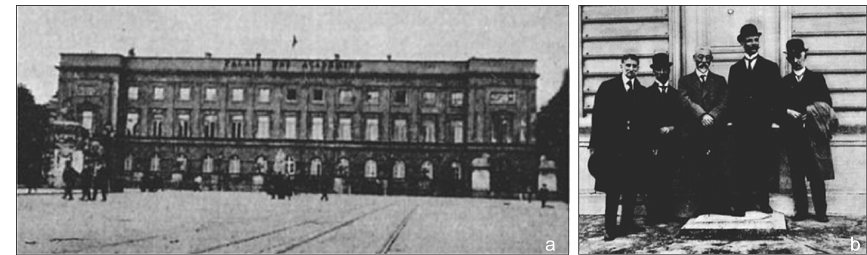
Figure 3. The inaugural IRC General Assembly and establishment of IUGG. (a) Palais des Academies at Brussels, Belgium, where the IRC assembly was held in July 1919; (b) IUGG officers: (from left to right) Louis A. Bauer, V. Reina, Aikitsu Tanakadate, Hermant, and Charles Chree participating in the Assembly (Bauer,